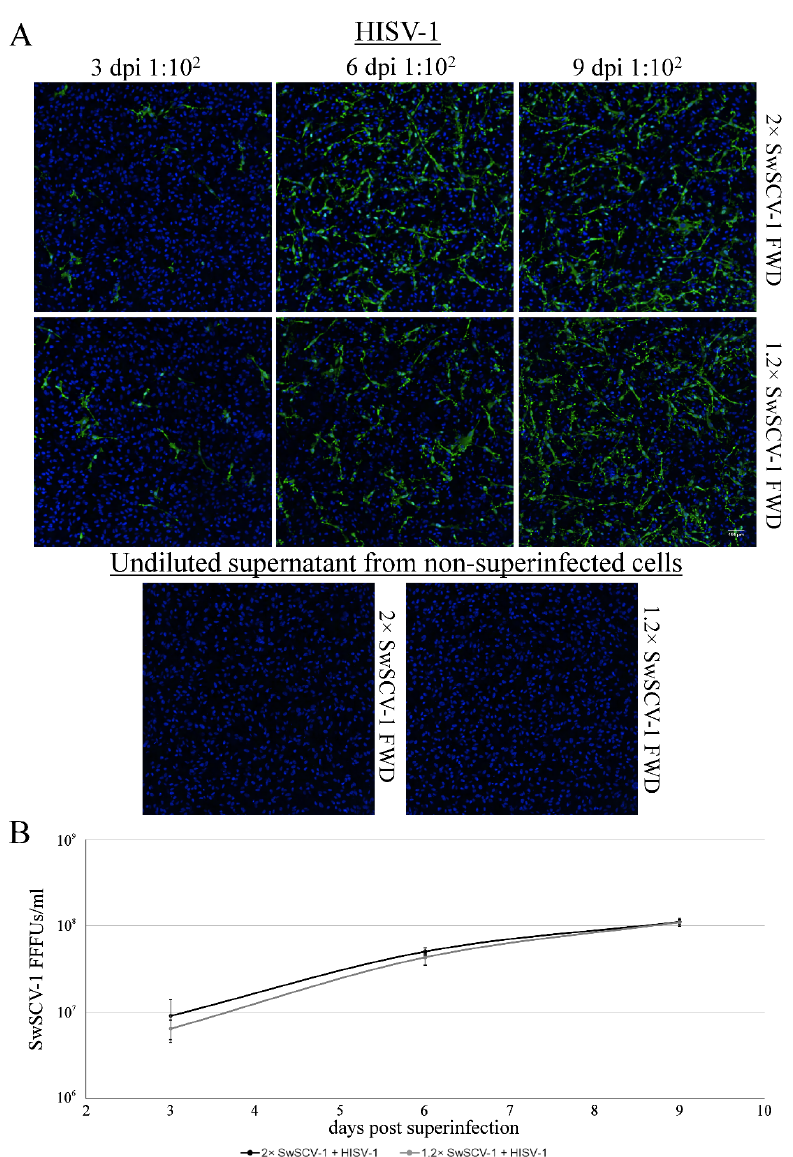
Figure 5. Superinfection of 2× and 1.2× SwSCV-1 FWD transfected I/1Ki cells leads to infectious particle production. ( A ) Supernatants collected at 3, 6, and 9 days post HISV-1 superinfection from I/1Ki cells—transfected with 2× and 1.2× SwSCV-1 FWD constructs two weeks earlier—were used to inoculate clean I/1Ki cells. At four days post inoculation, the cells were fixed and stained using rabbit α -SwSCV-1 DAg antiserum and Alexa Fluor 488-labeled donkey anti-rabbit secondary antibody. Hoechst 33342 served for staining the nuclei. The top panels show clean I/1Ki cells infected with 100-fold diluted supernatant originating from HISV-1 superinfected 2× SwSCV-1 FWD transfected cells, and the bottom panels with supernatant originating from HISV-1 superinfected